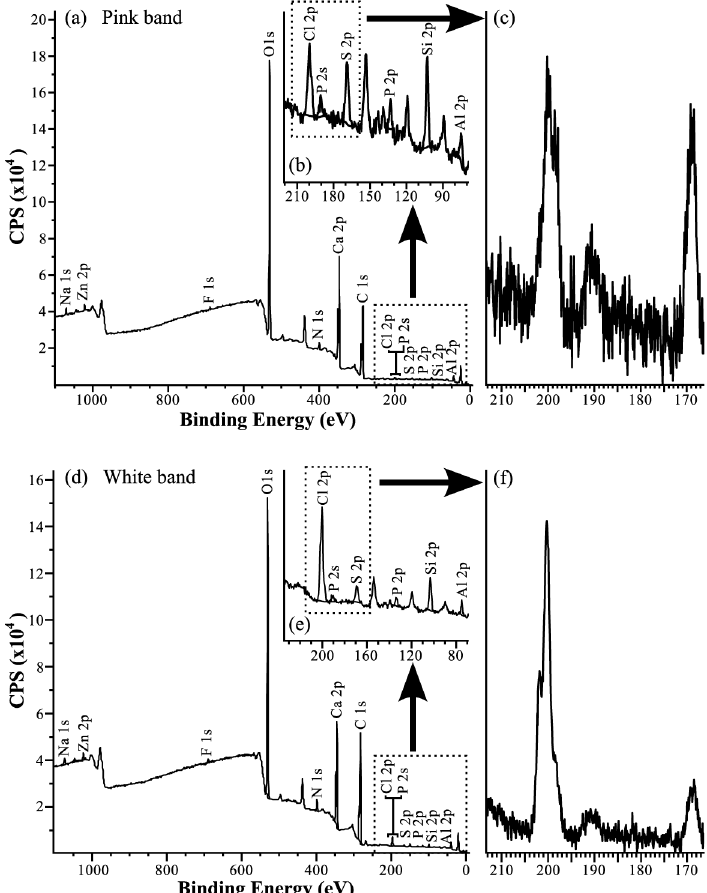
Fig 3. XPS spectra of the pink and white bands of UOM-232. Wide energy range scans are shown in (a) and (d), (b) and (e) show scans of 220 eV — 70 eV, and (c) and (f) show high resolution scans of the Cl 2p, P 2s and S 2p peaks. Due to the presence of phosphate the phosphorus peak 2s peak occurs in the same range as the boron peak (190 eV — 191 eV) meaning boron could not be resolved. doi:10.1371/journal.pone.0138305.g003 Table 2. Quantification data of elements present in UOM-232 shown by X-ray photoeletron spectroscopy. Element and